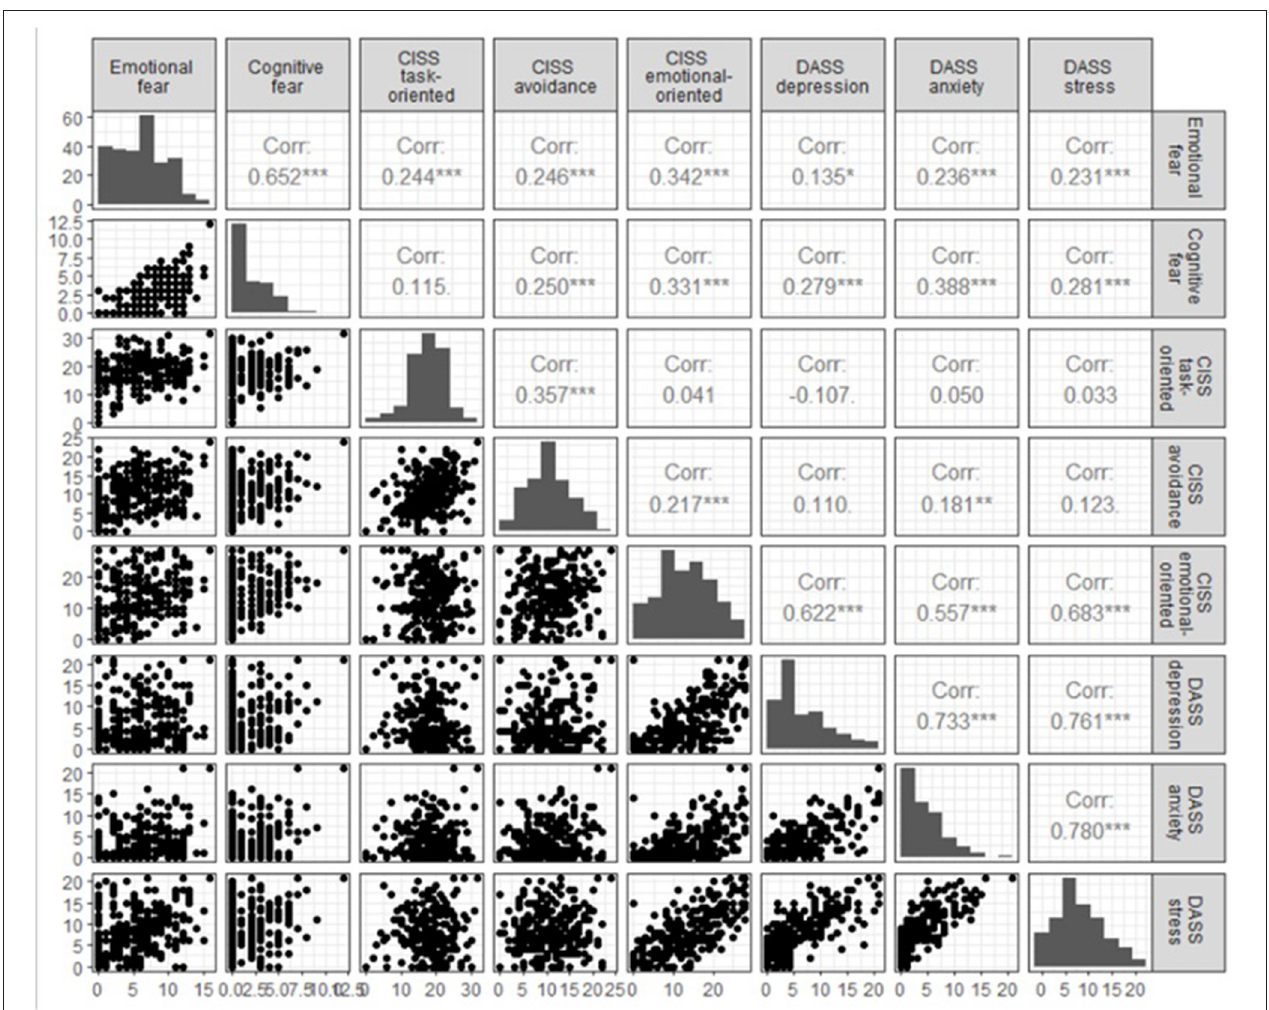
FIGURE 1 | Empirical distribution of scales and Pearson’s linear correlation coefficient between the scales * p < 0.1, ** p < 0.05, *** p <